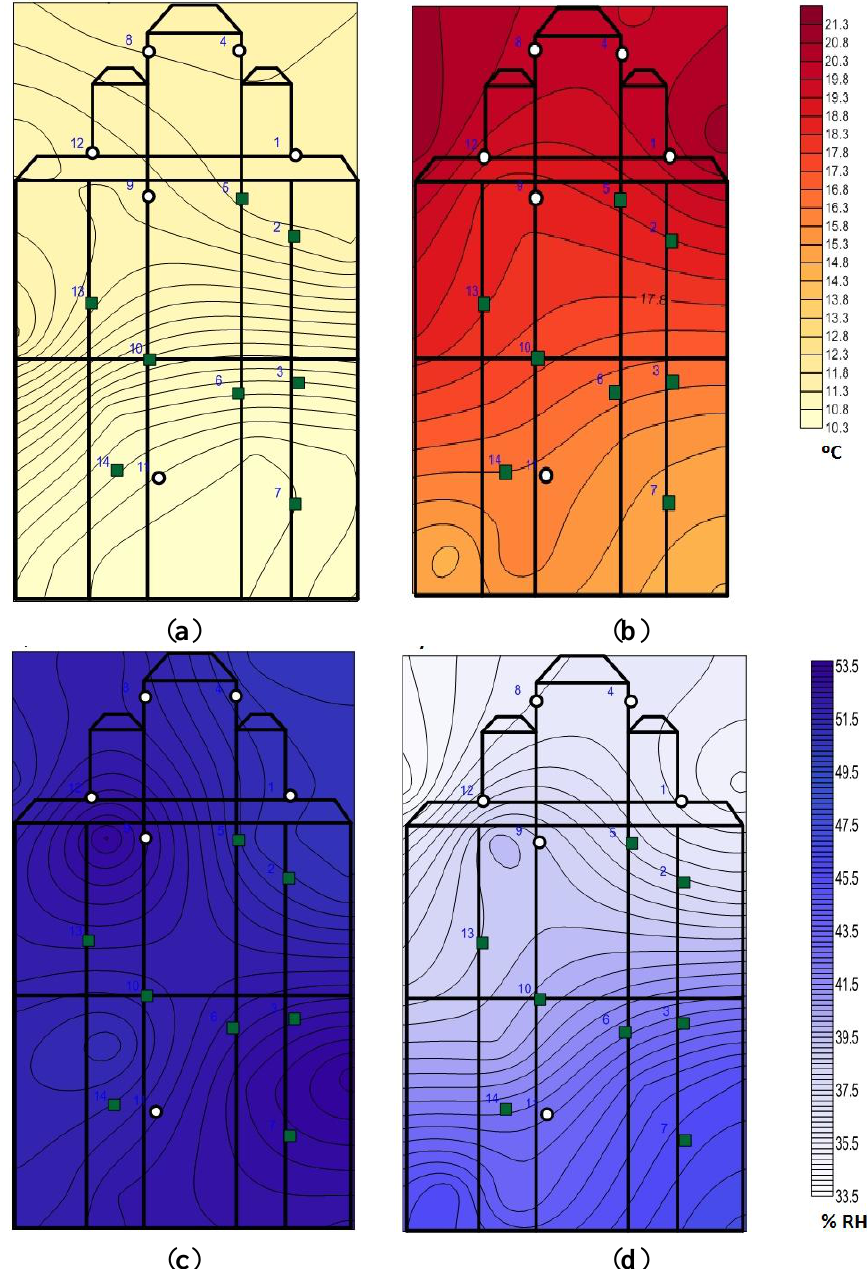
Figure 7. Contour plots for days when the heating system is switched on, ( a ) for the average temperature before switching (2 h), ( b ) maximum temperature during the system is switched on, ( c ) for the average RH before switching (2 h), and ( d ) minimum RH during the system is switched on. Circles represent sensors on the back of the altarpiece and squares represent those sensors located in the front of